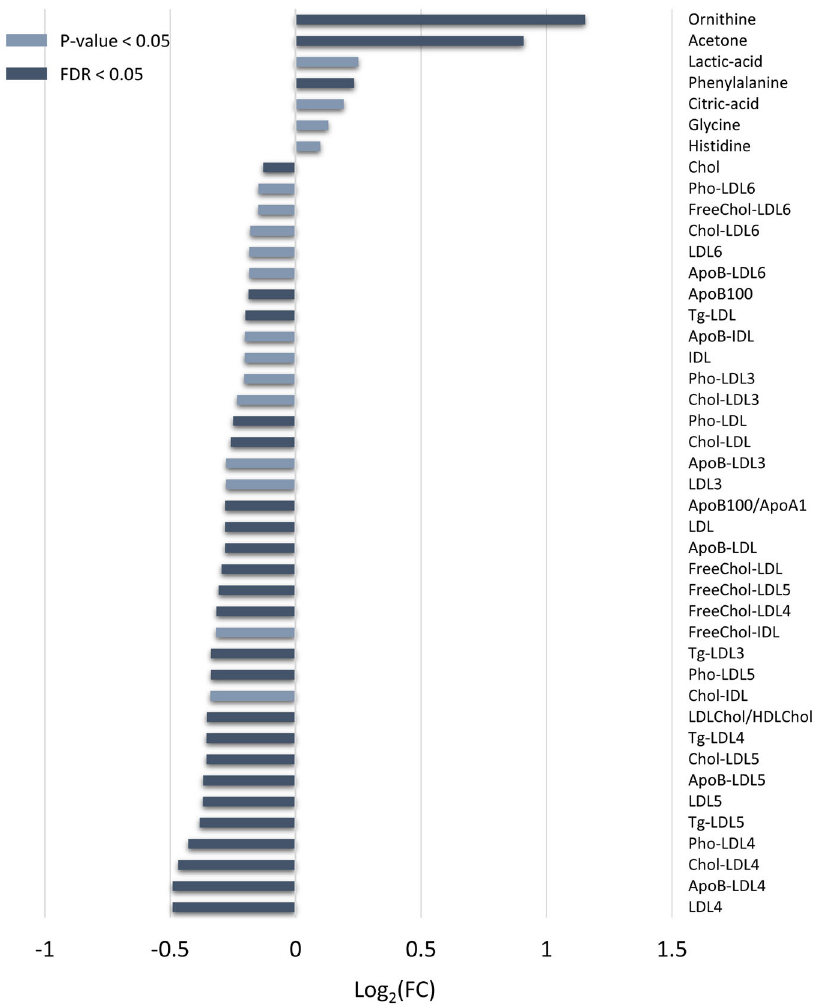
Fig. 3 Bar-plot of Log 2 fold changes values (Log 2 FC). Statistically signi fi cant variables (FDR < 0.05) quanti fi ed in serum spectra of the male subjects belonging to the training cohort are reported. Negative Log 2 FC values mean higher concentrations in CTR subjects, while positive Log 2 FC values refer to higher concentration levels in dn 2